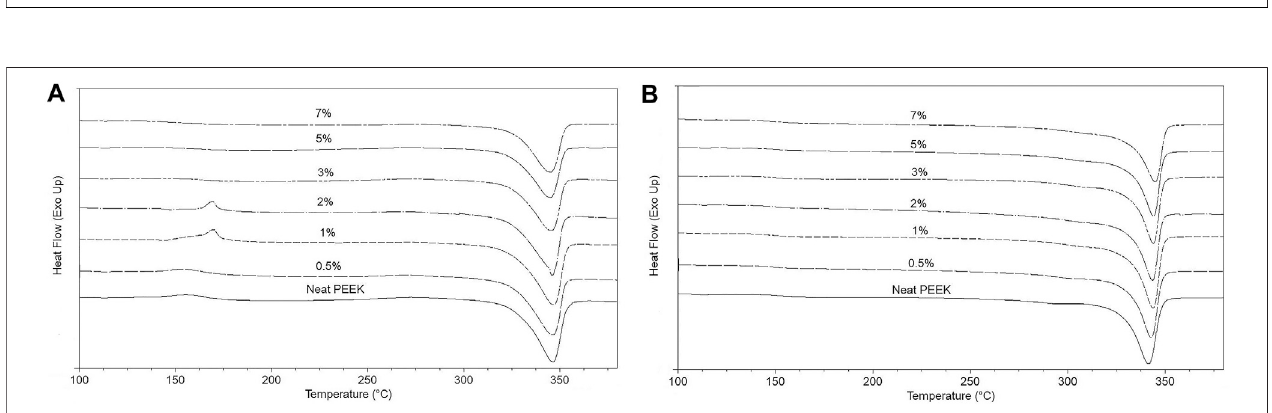
Frontiers in Materials |